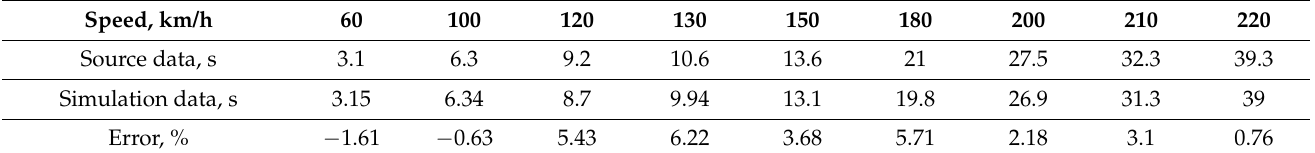
Table 2. Comparison of acceleration data by source [22] and by the model simulation.